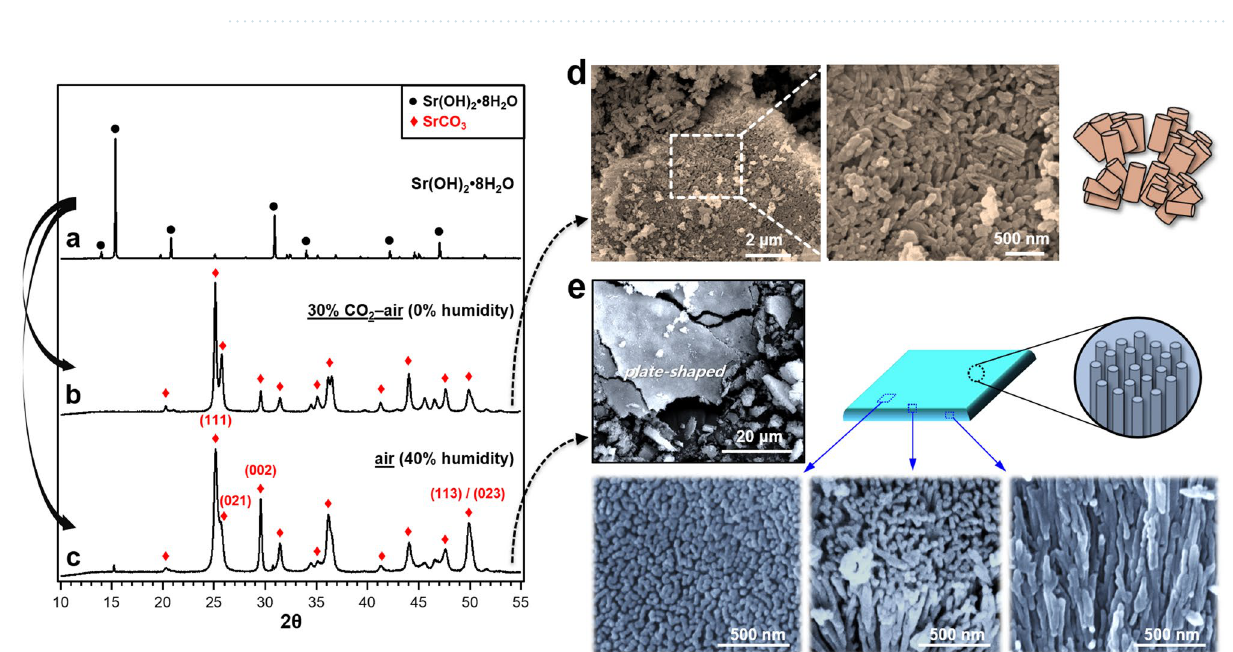
Figure 3. XRD patterns of Sr(OH) 2 ·8H 2 O before and after exposure to an ambient room air (1.2% H 2 O present, and 400 ppm CO 2 ) and a CO 2 -air mixed gas (H 2 O absent, and 30% CO 2 ) for 24 h ( a – c ), and their corresponding SEM images ( d , e XRD patterns of the SrCO 3 with preferred orientation in (002) plane (Fig. 4a: right insets). This simulation result is well matched to the measured one in Fig. 3c, suggesting that the SrCO 3 nanorod grows preferentially at (cid:31) 001 (cid:30) direction (i.e., along c -axis). TEM analysis was performed to further validate the above results. Figure 4b,c show SEM and TEM images of nanorods grown from Sr(OH) 2 ·8H 2 O in humid condition. The low- and high-resolution (HR) TEM images of a single nanorod in Fig. 4d,e show fringes parallel to the growth direction of the nanorod (marked by arrows), indicative of planar defects. The FFT patterns of selected areas in Fig. 4e are displayed in Fig. 4f–h. The diffraction